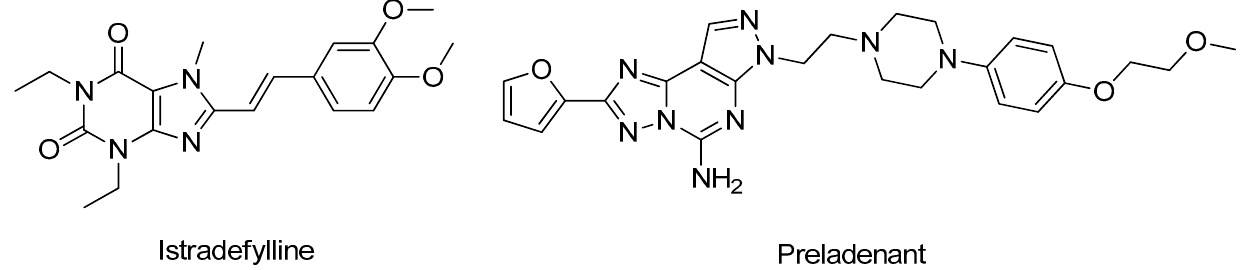
Figure 20. Structures of the clinically approved adenosine receptor A 2A antagonists.